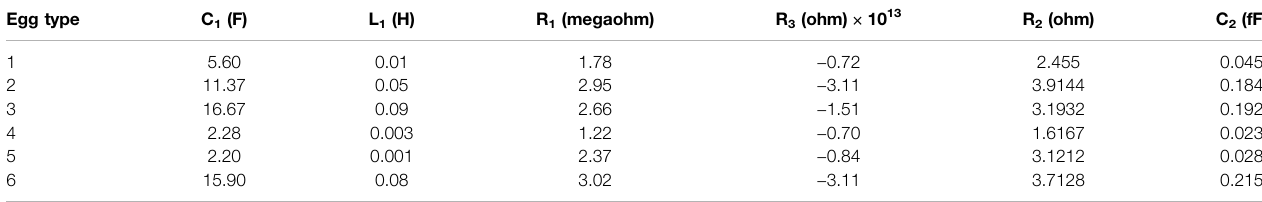
TABLE 1 | Electrical parameters related to the equivalent circuit.